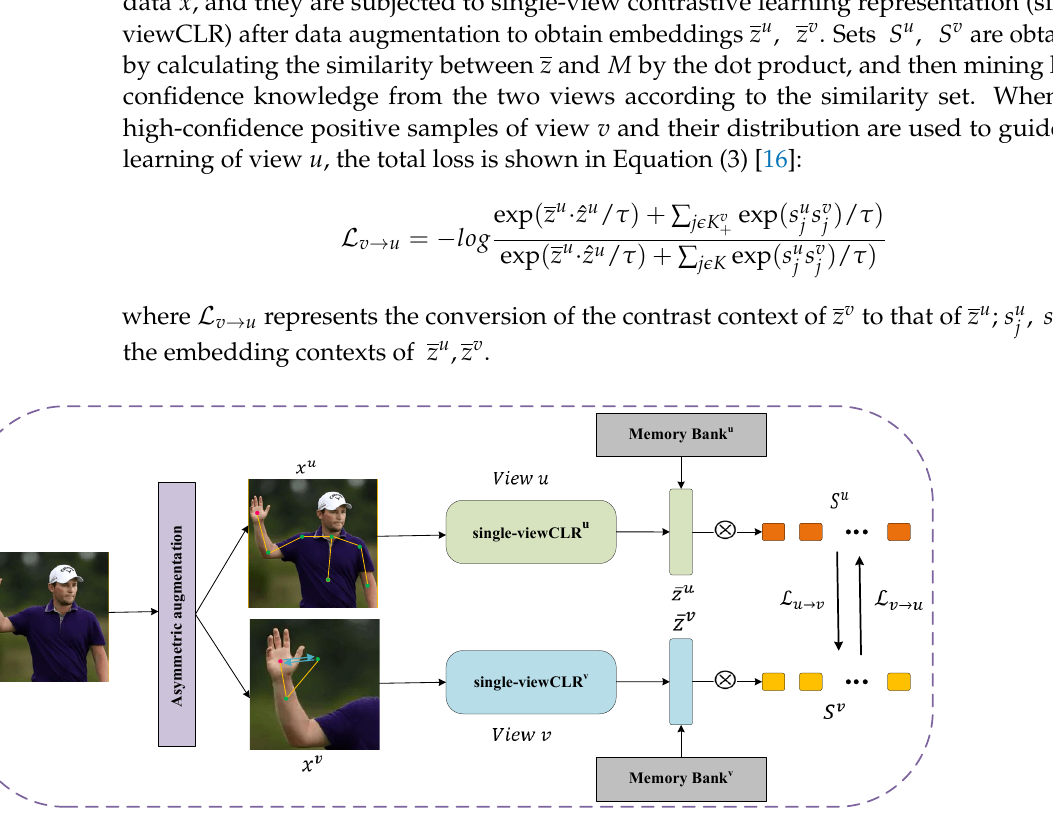
Algorithm 2. Main algorithm of Composite framework